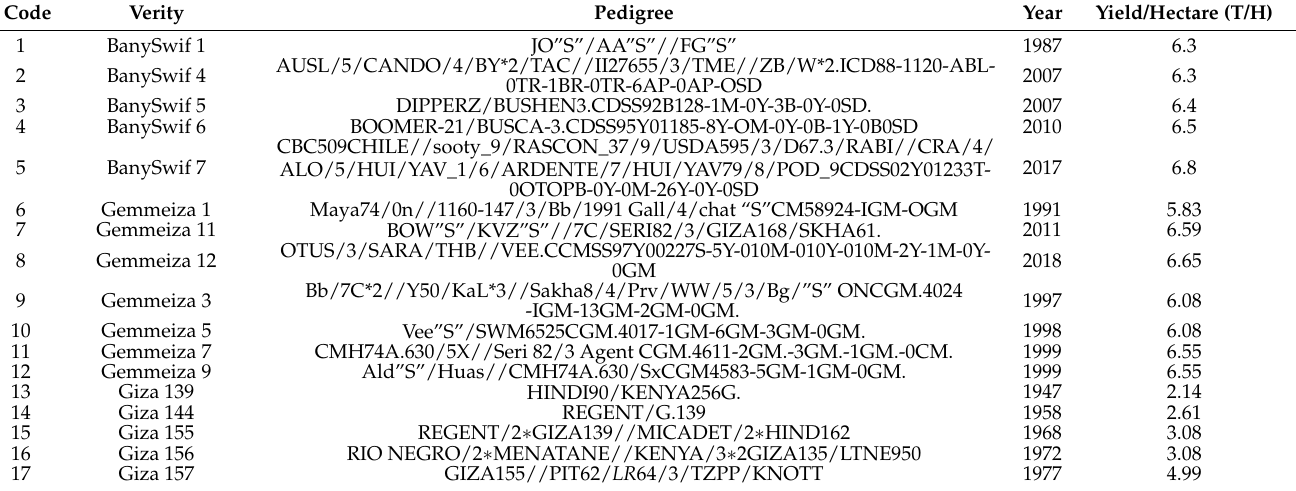
Table 6. Pedigree and year of release of the wheat varieties under